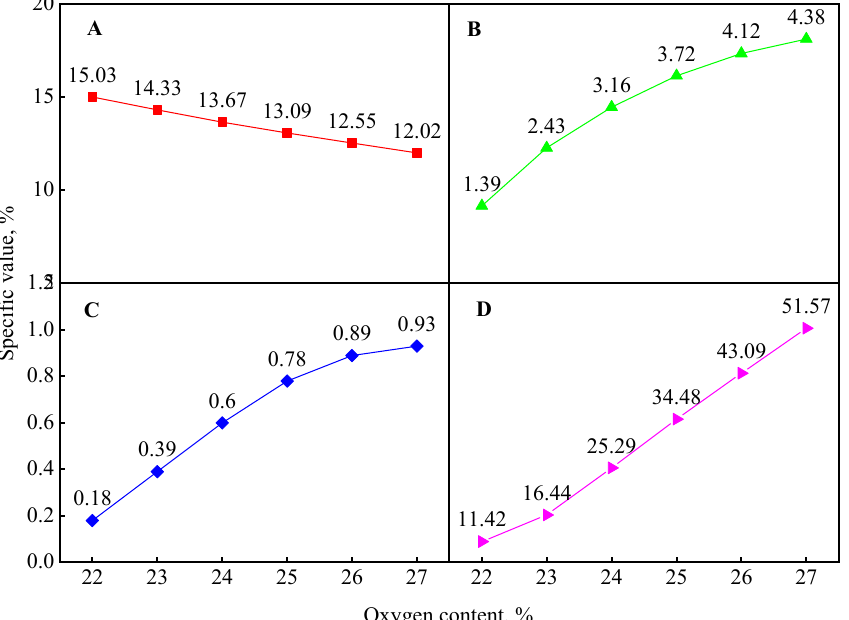
Figure 11. Different elements concentration, ( A ): CO/N 2 , ( B ): C 18 O/N 2 , ( C ): C 18 OO/N 2 , ( D ): 18 O 2 conversion ratio. Processes 2021 , 9 , x FOR PEER REVIEW